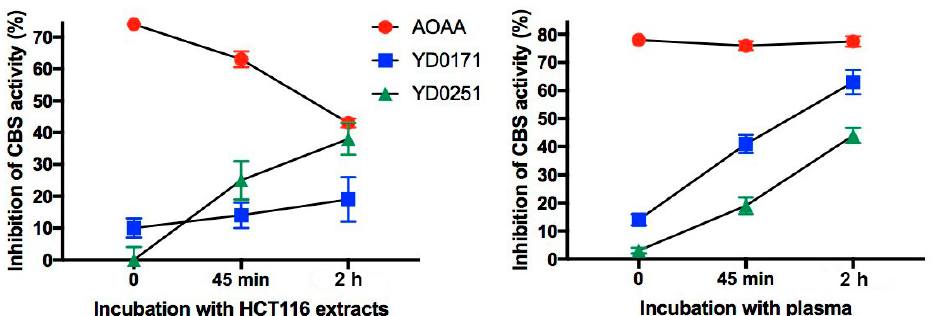
Figure 3. Comparison of the CBS inhibitory activity of AOAA, YD0251, or YD0171 before and after incubation in cytosolic extracts of HCT116 cells (left panel) or mouse plasma (right panel). Each compound was added to the biofluid to give a final concentration of 30 µ M. At time 0 min, 45 min, or 2 h, the recombinant CBS was added and CBS-mediated H 2 S production was measured using AzMC. Inhibition of CBS activity was calculated as follows: ((vehicle-treated CBS activity—AOAA or prodrug-treated CBS activity)/vehicle-treated CBS activity) × 100. Data points are mean values ± SEM from 3 independent experiments.